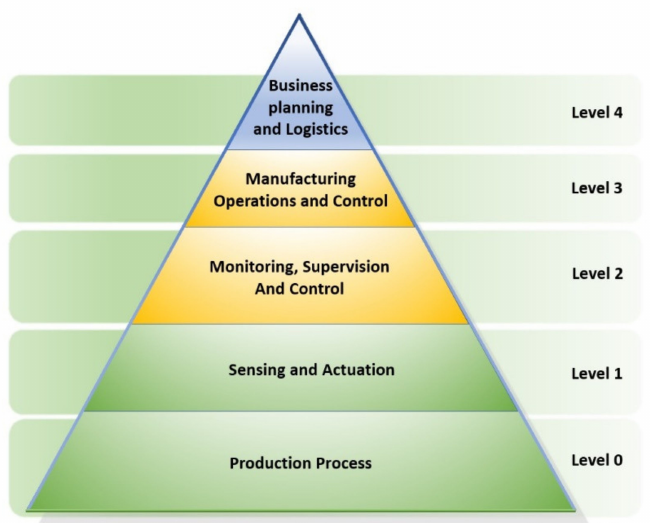
Figure 3. Industrial production functional hierarchies, according to IEC